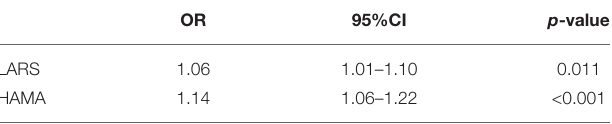
TABLE 4 | Correlative clinical factors of SCCs in the patients with LOPD. OR 95%CI p -value